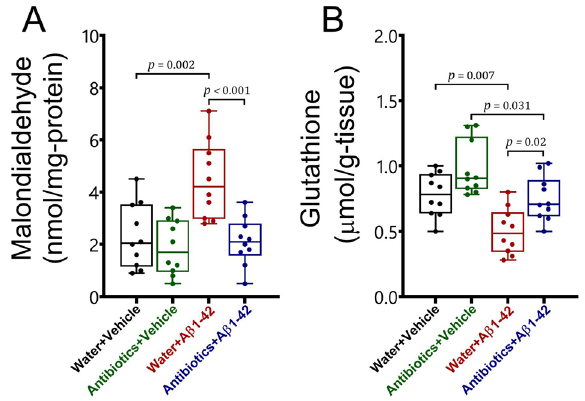
Figure 4. The effects of antibiotic treatment alone or in combination with Aβ1–42 treatment on oxidative stress and antioxidant markers ( A malondialdehyde; B glutathione) in the brain of male C57BL6 mice. Data are expressed as mean ± SEM (n = 10). Antibiotic treatment alone did not affect malondialdehyde and glutathione levels in the brain of mice [ p > 0.05] as compared to the water + vehicle group. On the other hand, Aβ 1–42 treatment significantly increased malondialdehyde [ p = 0.002] and decreased glutathione [ p = 0.007] in water- treated mice as compared to the water + vehicle group. In addition, Aβ 1–42 administration significantly reduced glutathione [ p = 0.031], whereas did not affect malondialdehyde levels [ p > 0.05] in the brain of antibiotic-treated mice as compared to the antibiotics + vehicle group. However, no significant differences in these markers existed between antibiotics + Aβ 1–42 and water + vehicle groups [ p > 0.05]. Furthermore, there were significant differences in malondialdehyde [ p < 0.001] and glutathione [ p = 0.02] levels in the brain between water + Aβ 1–42-treated animals and antibiotics + Aβ 1–42